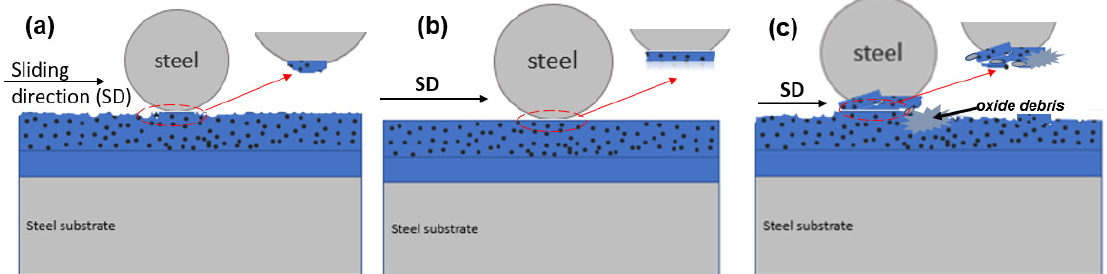
Coatings 2021 , 11 , x FOR PEER REVIEW 12 of 16 Figure 11. The transition in wear is proposed to have occurred by ( a ) high loss rate as the film formed with high friction (Figure 6: running-in friction of ENP1, ENP2 and ENP3), ( b ) much lower loss rate after the film formed where the tribo- system remained steady (i.e., constant friction and wear conditions; Figure 13b, 13e: ENP2 and 13f: ENP3), and ( c ) higher loss rate from the film due to fragments (Figure 13a: ENP1) or total film loss due to cyclic sliding (Figure 13d: ENP1) and material gain on the hard coating from abrasive-adhesive wear of the steel counter body (Figure 13c: ENP3).